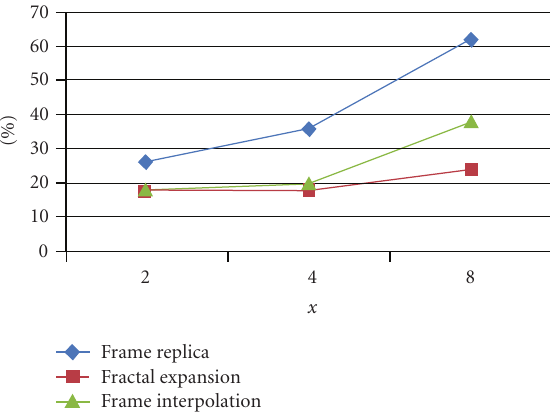
Figure 10: Measured tiling for CrowdRun sequence.